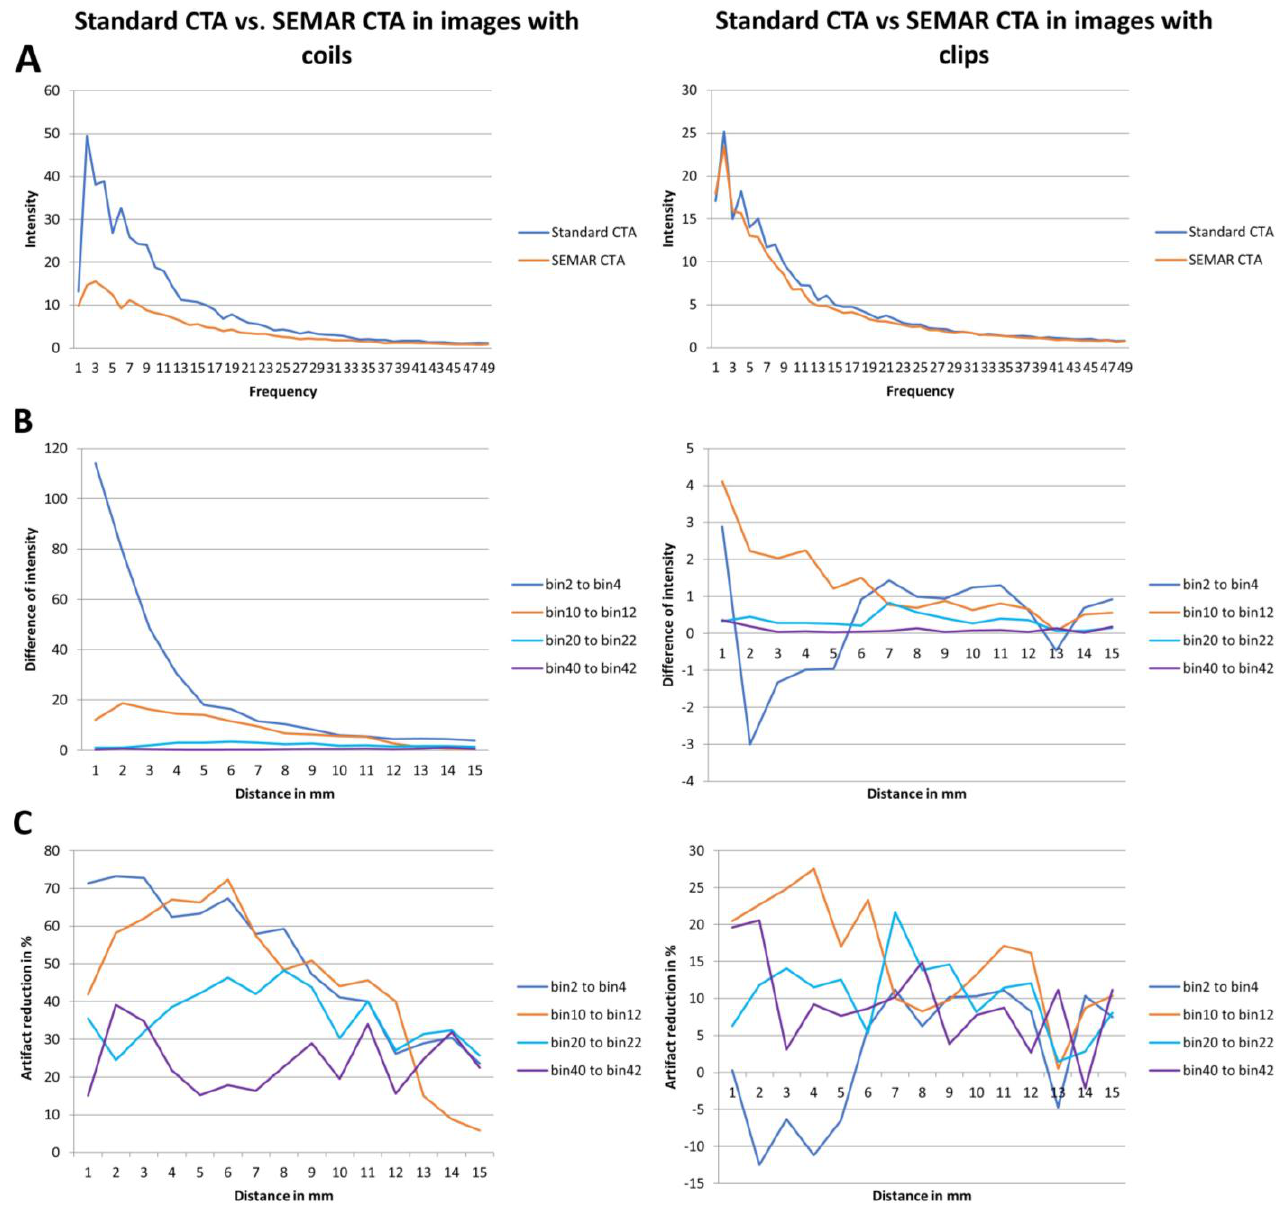
Figure 5. Results of frequency and intensity analyses in images with coils/clips. ( A ) Intensity of the metal artifacts of standard and SEMAR CTA images in different frequencies (bin 1 to 49). ( B ) Differences of the metal artifacts intensity in the four representative frequency fields in different distances (1 to 15 mm). ( C ) Artifact reduction of % in the four representative frequency fields in different distances (1 to 15 mm).